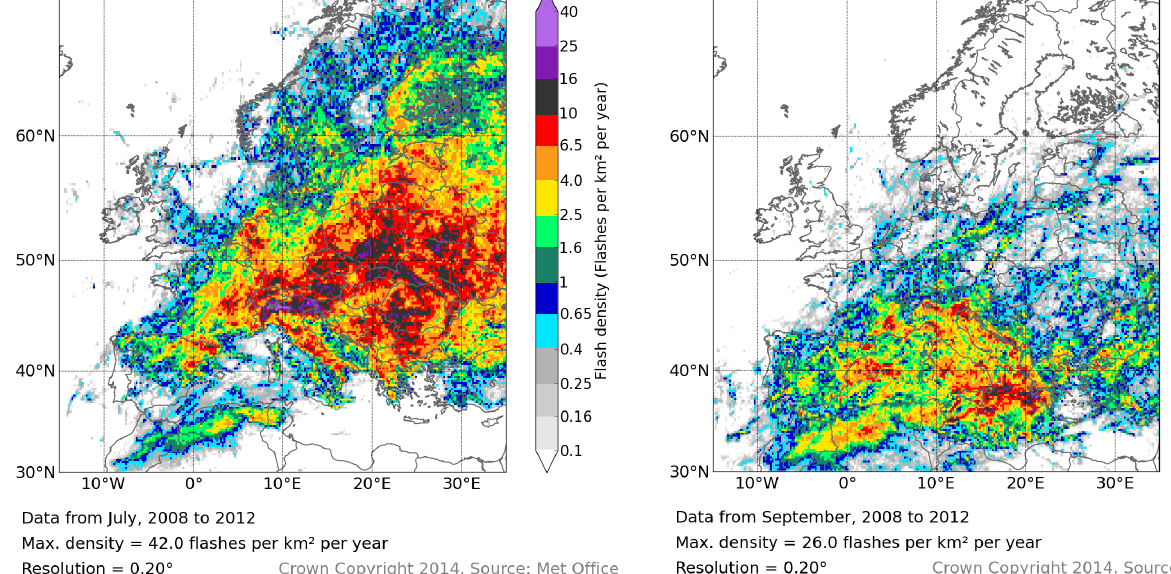
Fig. 11. Detected lightning flash density for July.